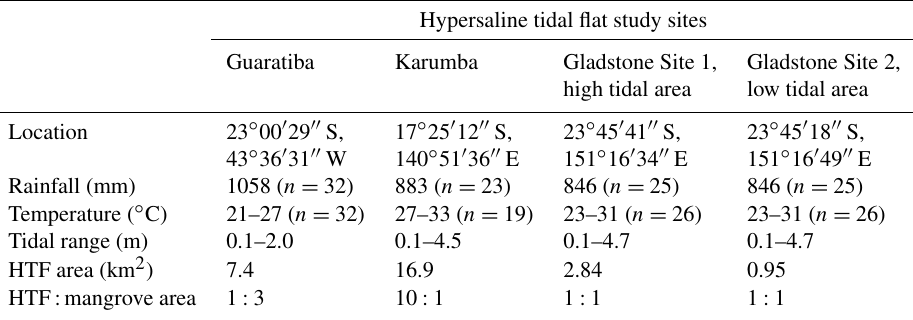
Table 1. Characterisation of study sites. Rainfall (mm) and temperature ( ◦ C) data are based on annual averages derived from monthly measurements ( n is number of years of data), and HTF:mangrove area indicates the ratio of hypersaline tidal flat area to mangrove area. Hypersaline tidal flat study sites Guaratiba Karumba Gladstone Site 1, Gladstone Site 2, high tidal